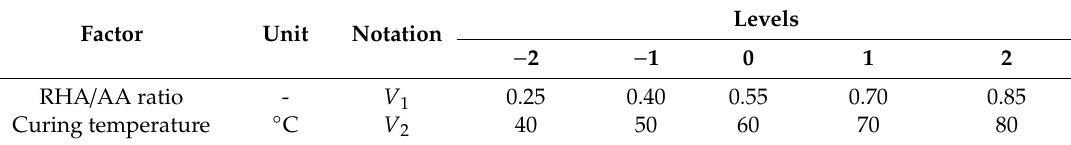
Table 2. Factors and levels used for adhesion test.